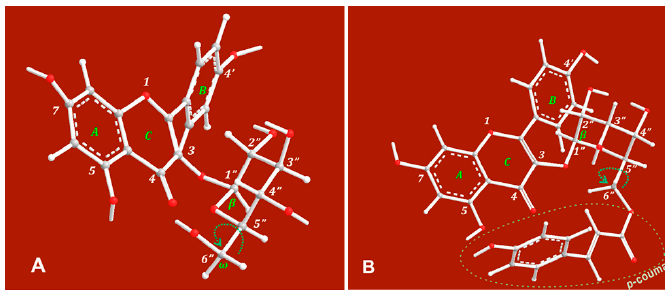
Figure 4. Ball-and-stick models based on preferential conformation of astragalin ( A ) and tiliroside ( B ).